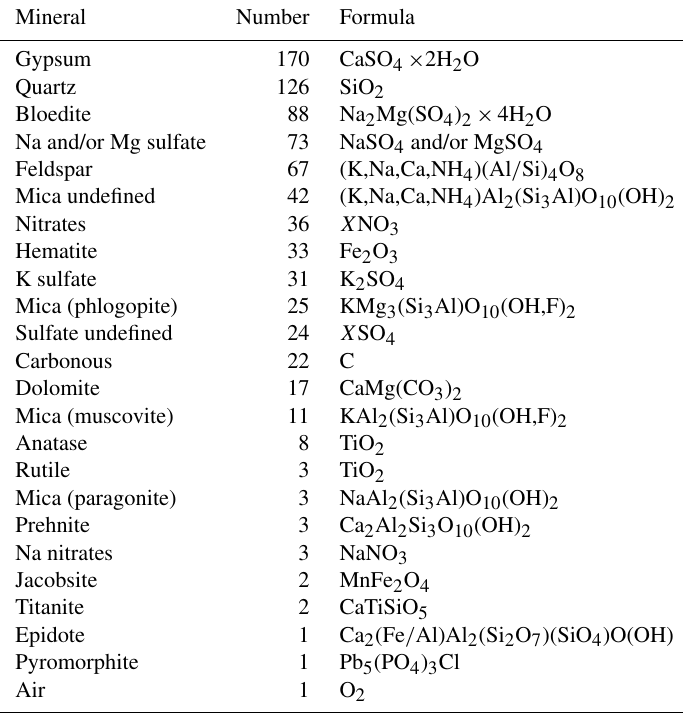
Table A1. Identified Raman spectra in the upper 1340m of the EGRIP ice